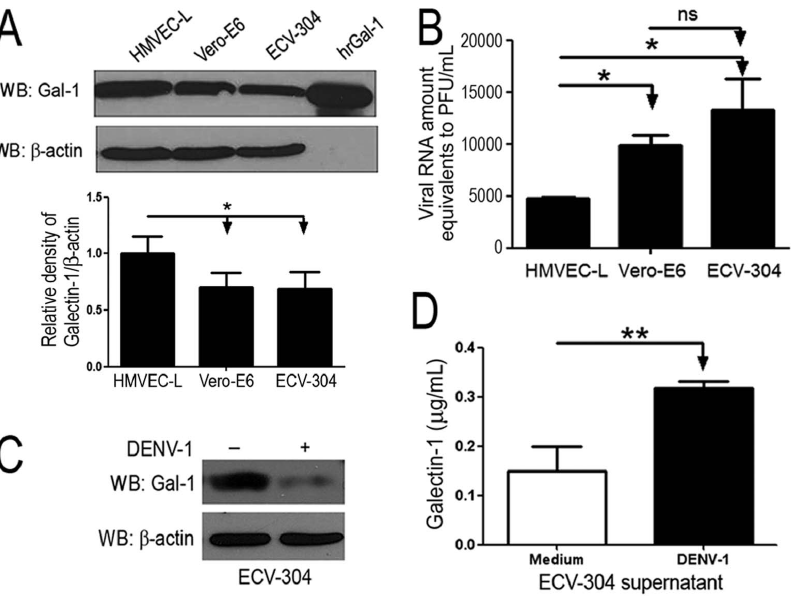
Figure 1. Lower expression of Gal-1 is correlated with higher viral loads produced by DENV-1-infected cells. (A) Gal-1 expression on HMVEC-L, Vero-E6 and ECV-304 cells was assessed by western blot method and normalized by b -actin endogenous control. The relative density of Gal-1 was determined by ImageJ software. (B) HMVEC-L, Vero-E6 and ECV-304 cells (2.5x10 4 ) were incubated with DENV-1 (MOI 0.5) for 72 hours at 37 u C. At the end of incubation period, the total amounts of viral RNA in the cell-free supernatants were determined by Real-Time PCR, using a standard curve constructed from DENV-1 RNA purified from 1x10 7 PFU (PFU: plate formed units). Results are shown as Viral RNA amount equivalents to PFU/ml 6 SD from 3 independent assays performed in triplicates. (C) ECV-304 cells were inoculated with DENV-1 (MOI 0.5) or only with medium and cultivated for 72 hours at 37 u C. Cells were analyzed for Gal-1 expression by western blot assay. (D) Soluble Gal-1 was detected in the supernatants from cell cultures using ELISA method (N=3). *p , 0.01; **p , 0.001.